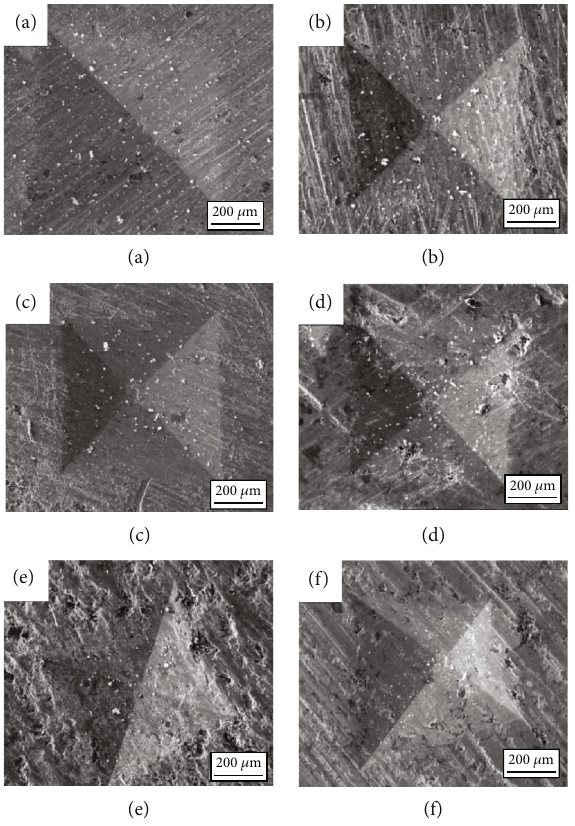
Figure 7: Vickers indentation of the SiC@Cu composites with di ff erent SiC@Cu